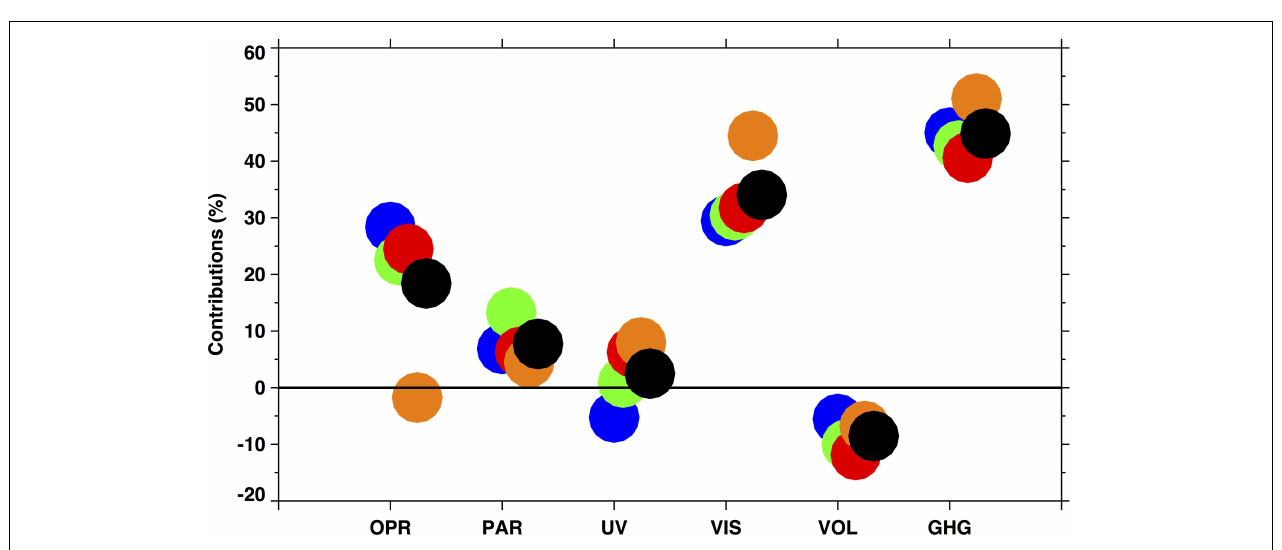
FIGURE 4 | Geographical distribution of annual mean temperature trend (K) during 1910–1940 time period calculated from the results of the first member of the model ensemble run ALL.